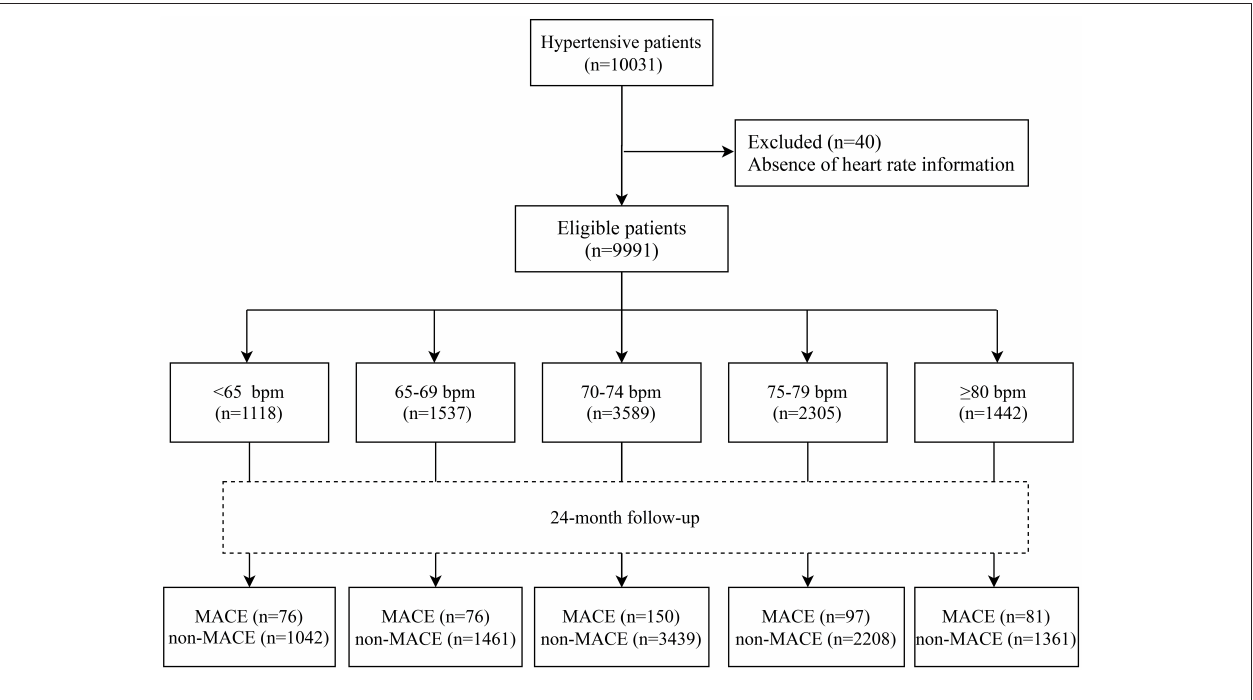
FIGURE 1 | Flow chart of patient